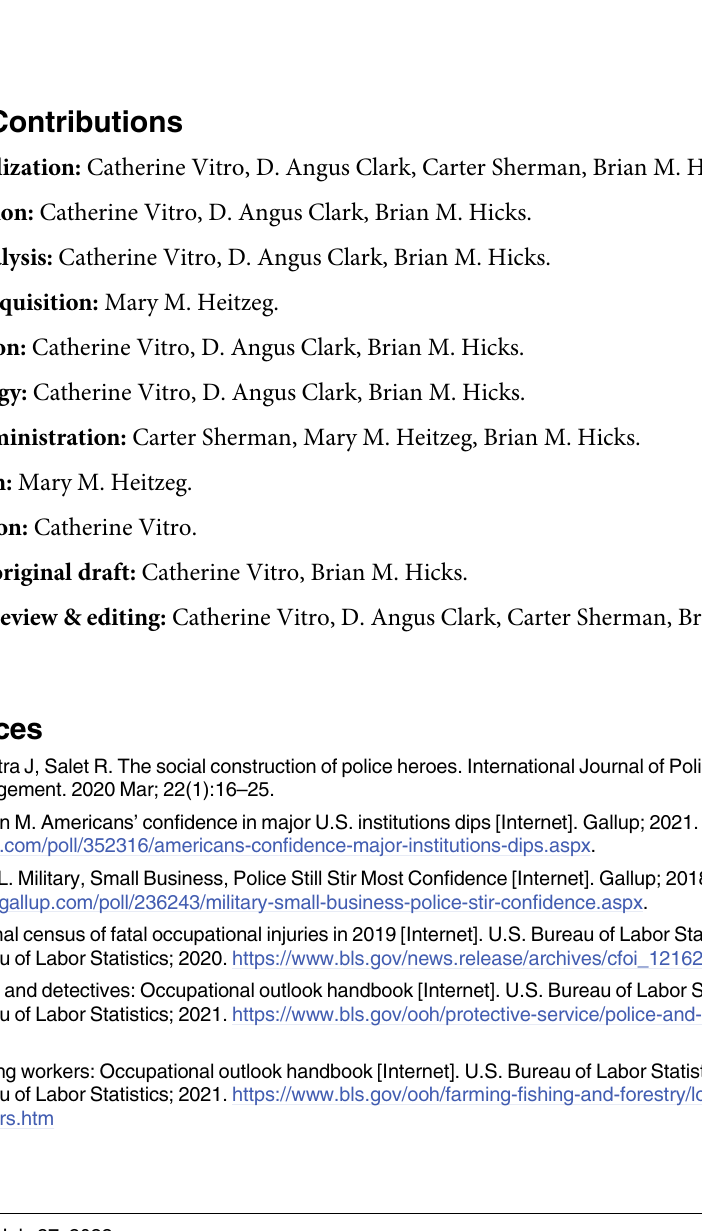
S1 Table. Descriptive statistics and mean differences in pro-police attitudes across racial groups. S2 Table. Descriptive statistics and mean differences in pro-police attitudes across political